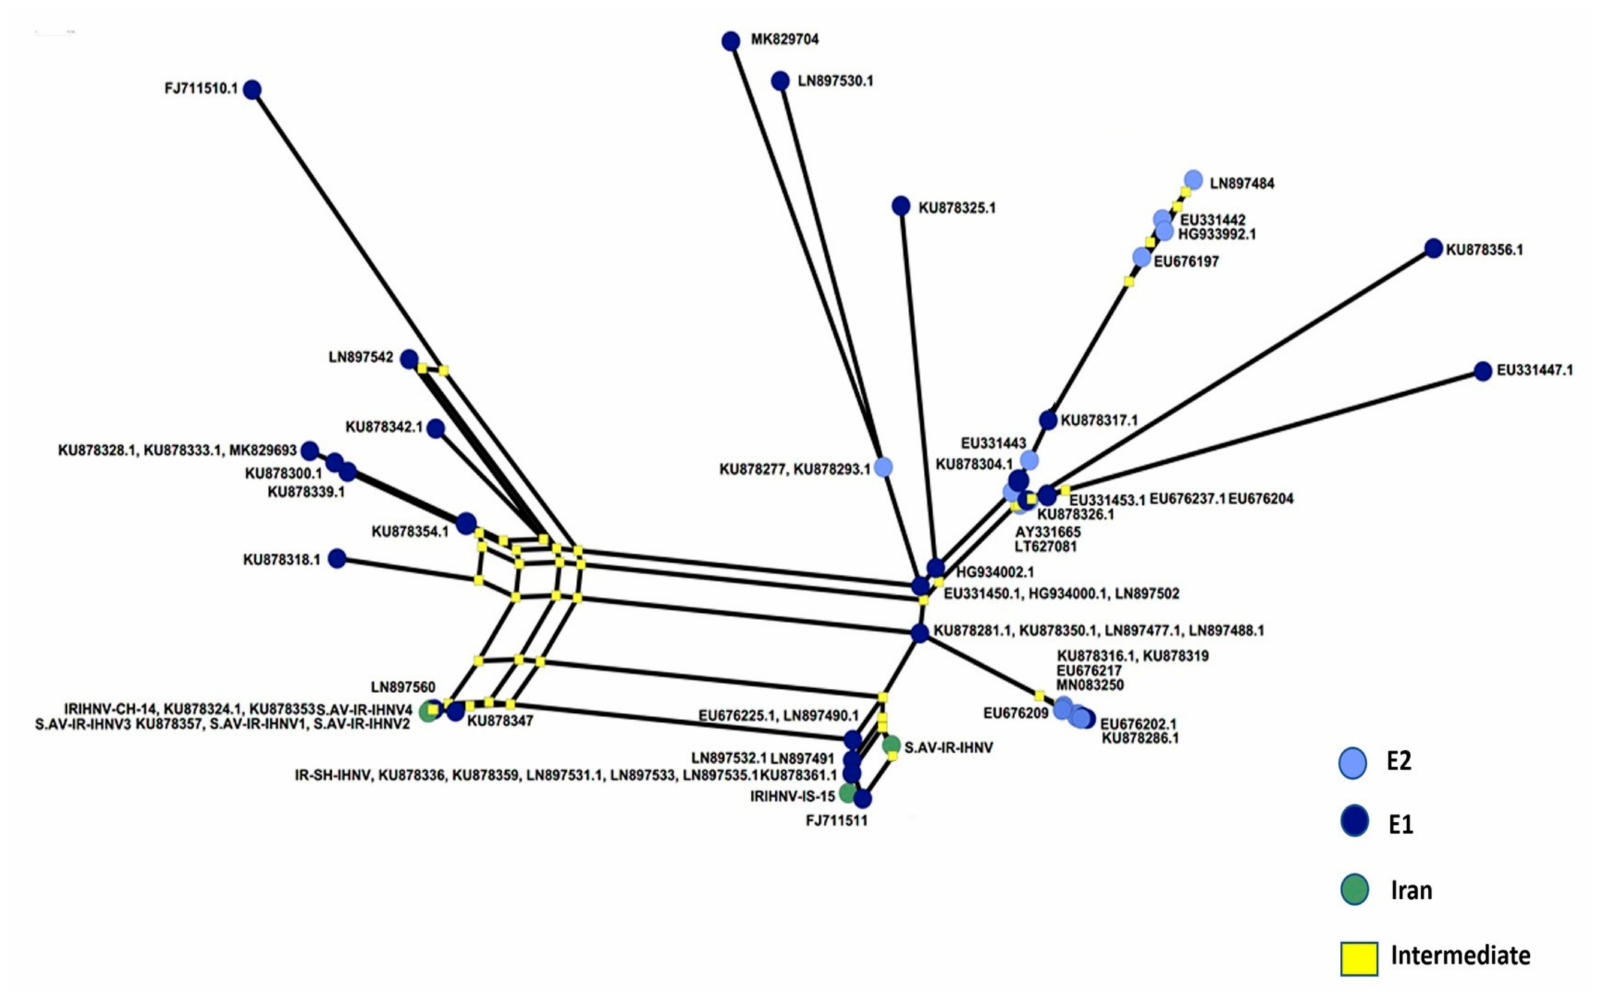
Figure 5. Neighbor network of non-homologous amino acids of IHNV glycoprotein fragment (303 bp mid G gene). IHNV sequences as indicated in Figure 4. Green circles indicate Iranian